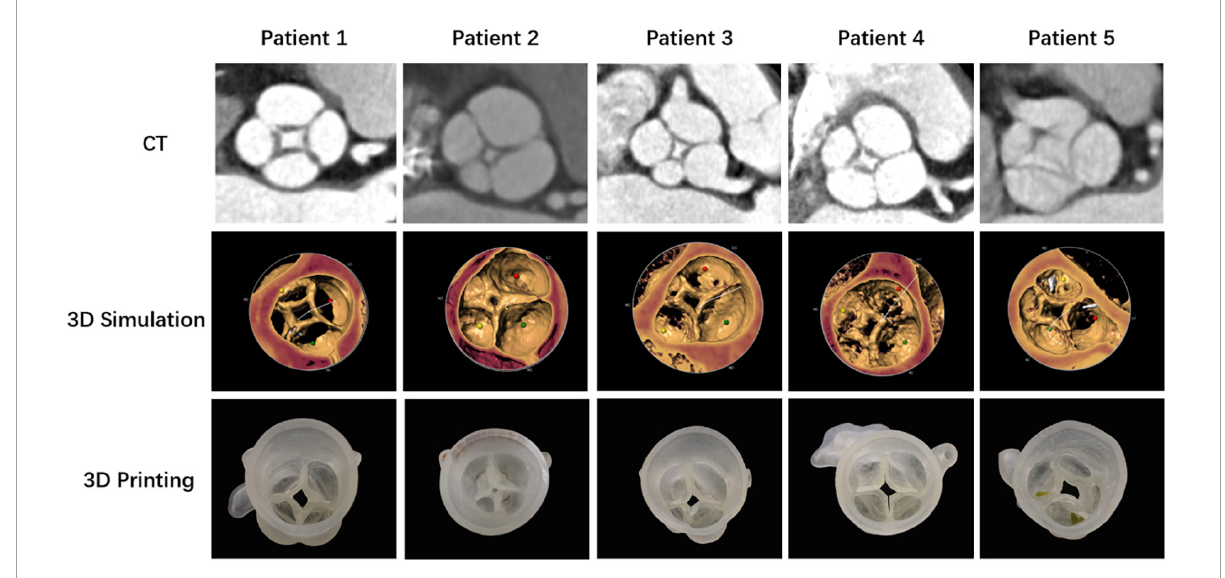
FIGURE1 Anatomical structures of the quadricuspid aortic valves of five patients demonstrated with computed tomography angiography (CTA), 3-dimensional (3D) simulation, and 3D printing